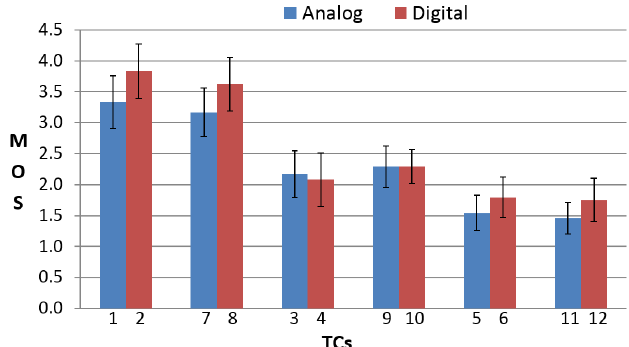
Figure 9. MOS results with 95% CI comparing analog and digital presentation of vehicle parameters being equal in the other